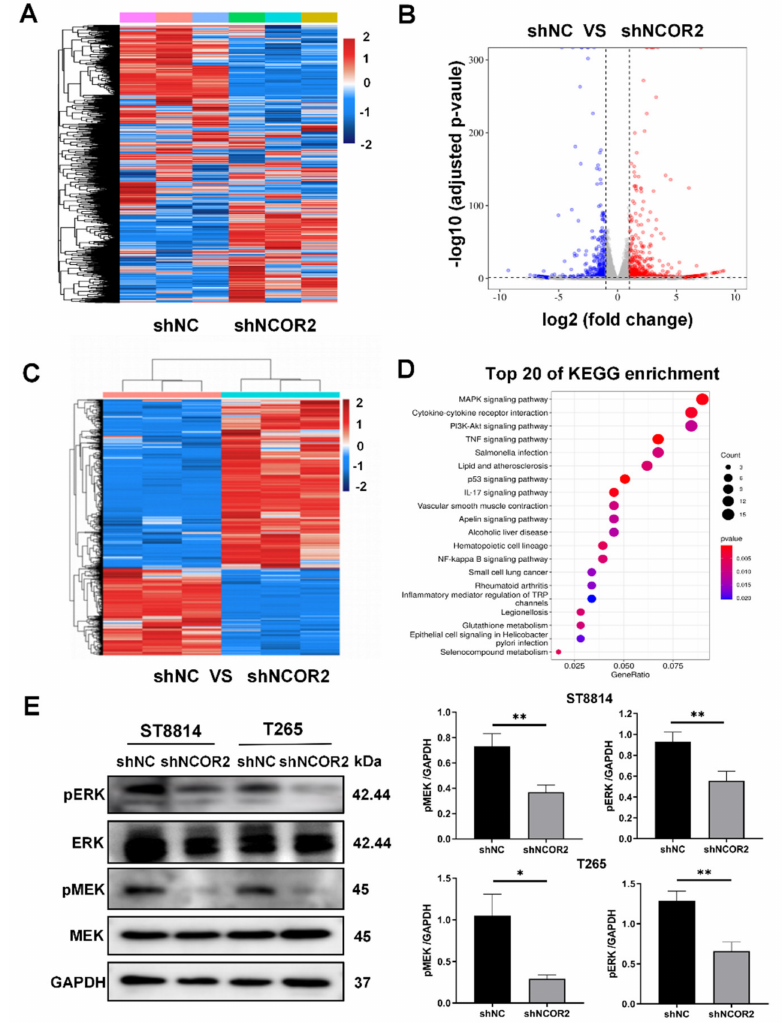
Figure 4. NCOR2 regulates the MAPK signalling activation in NF1-derived MPNST cells. ( A ) The total RNA was extracted from T265-shNCOR2 and shNC cells, and RNA-Seq profiling was per- formed. ( B ) Volcano plot of RNA-Seq results. Red plots represent significantly upregulated proteins, whereas blue plots represent significantly downregulated proteins in T265-shNCOR2 cells. Dashed lines indicate the significance threshold; p -adjust < 0.05, |Log FC| > 1. ( C ) Clustering analysis of significantly different expressed proteins. Blue, low expression; red, high expression; n = 6. ( D ) KEGG pathway enrichment analyses showing that attenuated activation of several tumourigenic pathways. ( E ) WB showing that NCOR2 knockdown altered the phosphorylation level of ERK1/2 and MEK1/2 in ST8814 and T265 cells. * p < 0.05, ** p <